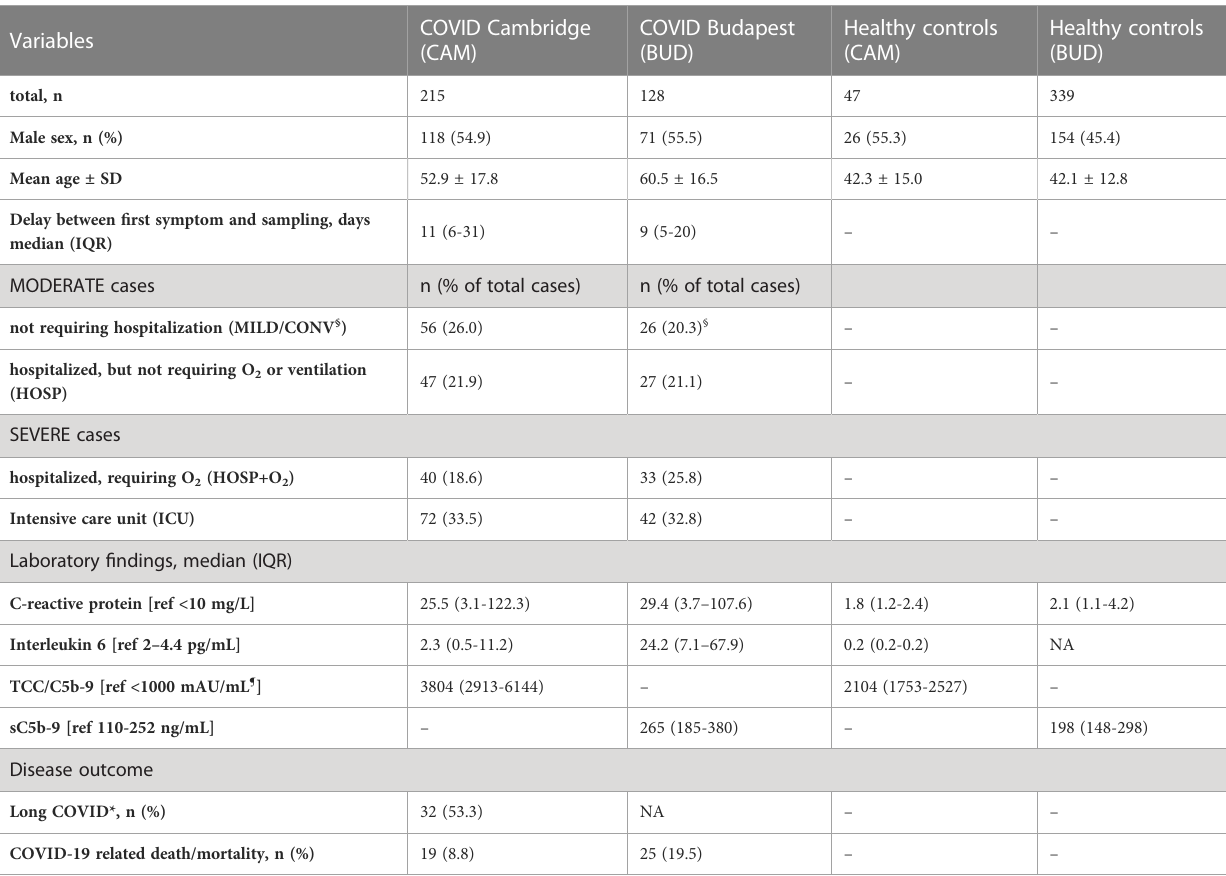
TABLE 1 Baseline characteristics of healthy controls and the two COVID-19 cohorts enrolled in Cambridge (CAM) and Budapest (BUD).